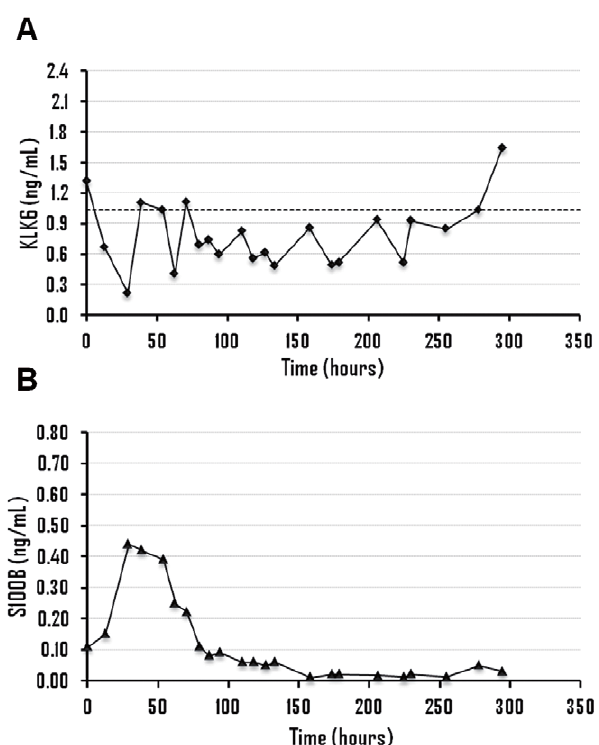
Figure 1. Time evolution of kallikrein 6 (A) and S100B levels (B), in ng/mL, for patient 12. The dashed line represents the lower reference limit of kallikrein 6 (1.04 ng/mL).